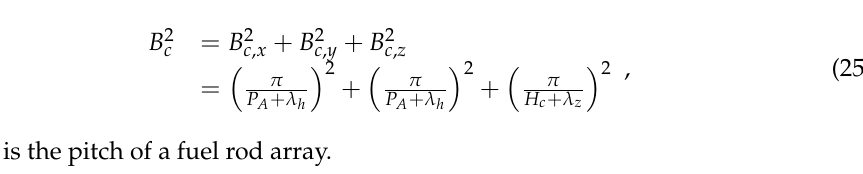
Table 2. Specifications of the selected TCA experiment benchmark problems. Problem No.